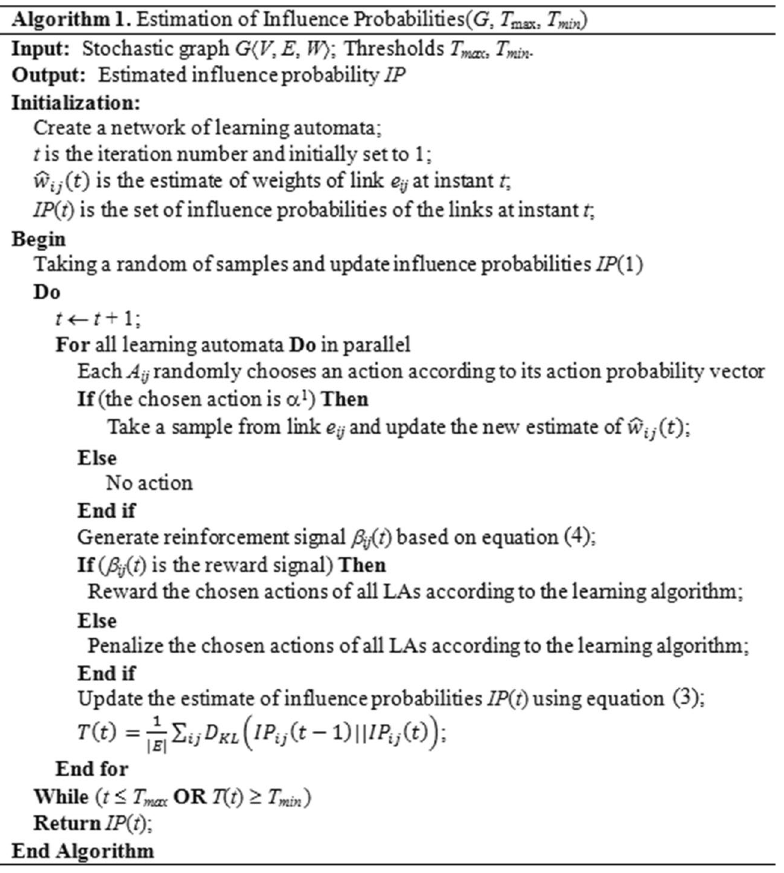
Figure 2. LA-IP algorithm for estimation of influence probabilities (LA-IP).